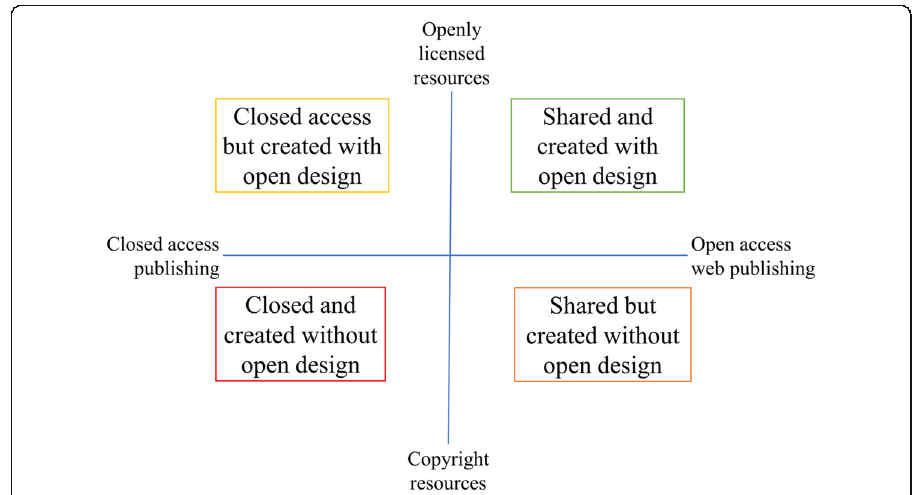
Fig. 3 Open and closed creation and publishing